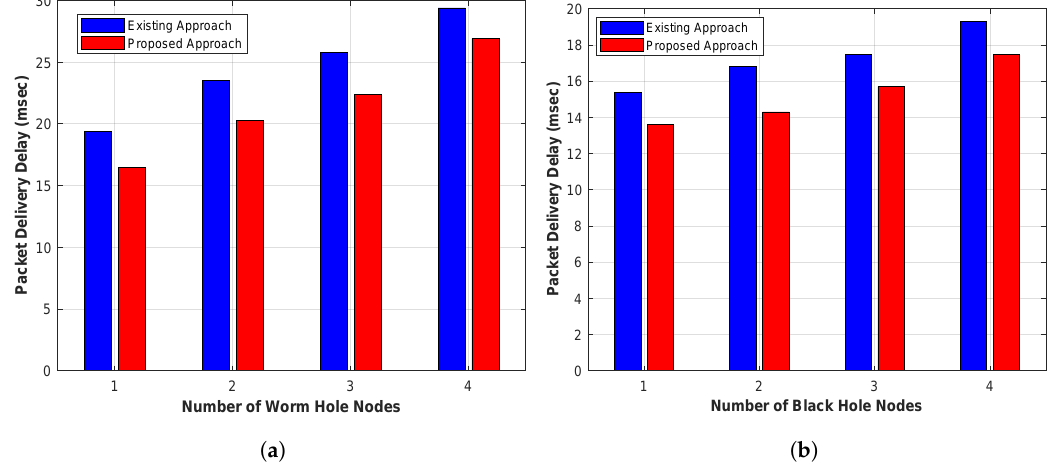
Figure 11. Packet delivery delay upon ( a ) increasing the number of worm hole nodes and ( b ) increasing the number of black hole